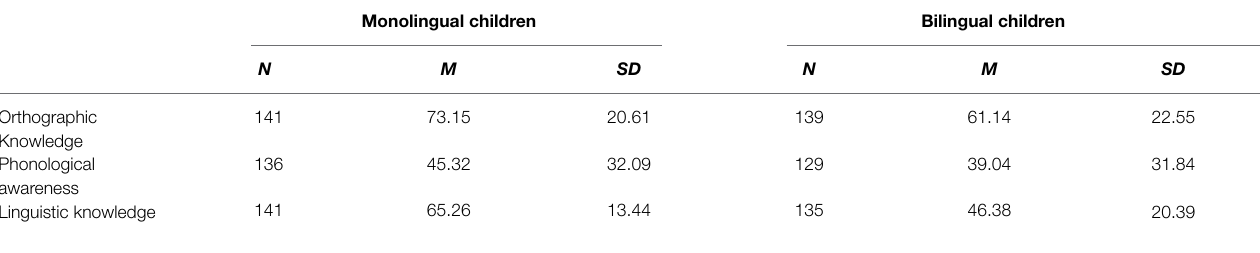
TABLE 3 | Means and SD of the different early literacy factors among the different groups of children. Monolingual